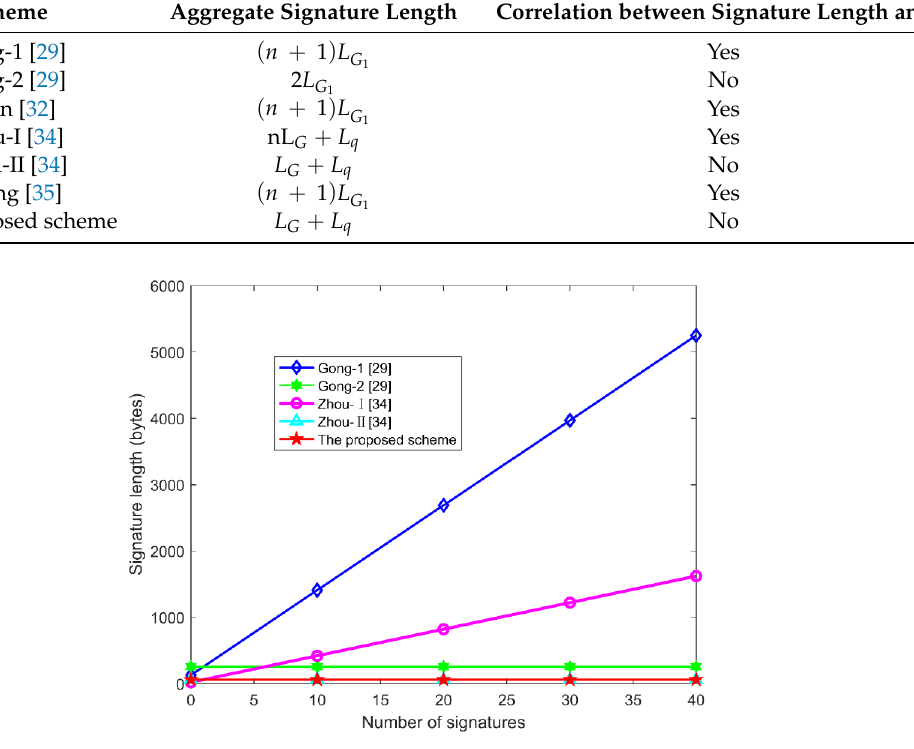
Figure 4. The comparison of signature length.